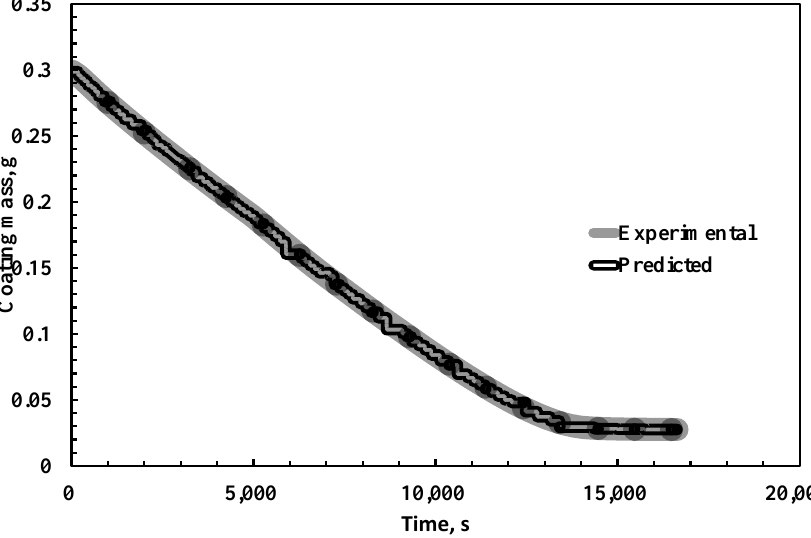
Figure 6. Comparison of model prediction with the experimental values for coating having 2005 micron initial coating thickness having poly(styrene) , p-xylene, and TPP , 5.02 %, 93.47%, and 1.51% respectively .